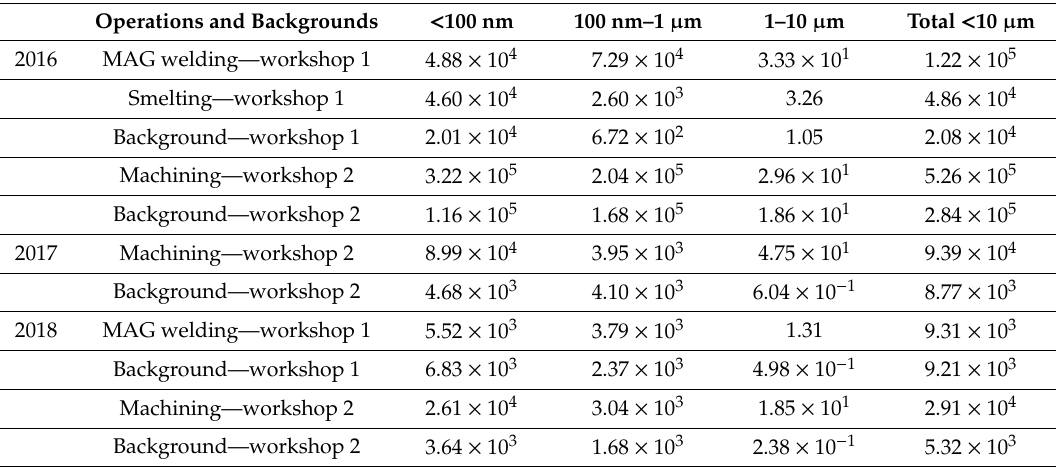
Table 4. Total number concentrations of three PM fractions (nano to 10 µ m) were measured by online monitoring (SMPS and APS) during the shift in individual working operations and backgrounds (medians for the respective time periods).